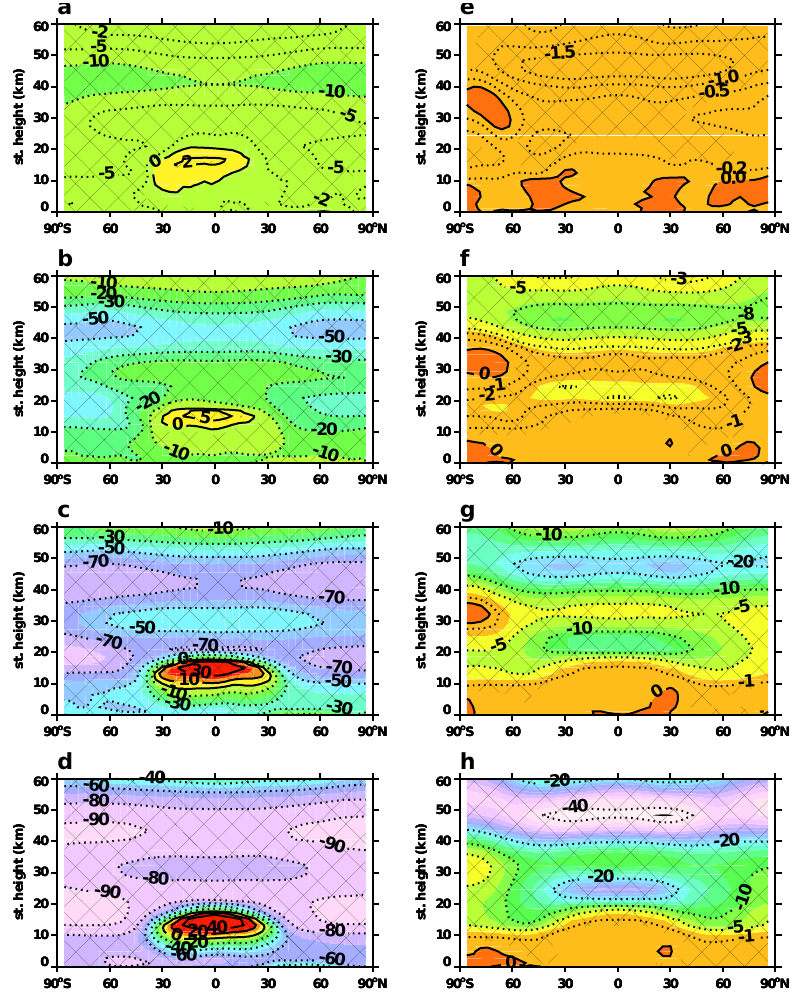
Fig. 1. Zonal mean annual mean ozone (a, b, c, d) (in %) and temperature (e, f, g, h) (in K) changes due to absence of the MPA regulations for decadal averaged time periods 1987–2012, 2025–2035, 2055–2065 and 2090–2100. Hatching represent the areas where the statistical significance exceed 95%